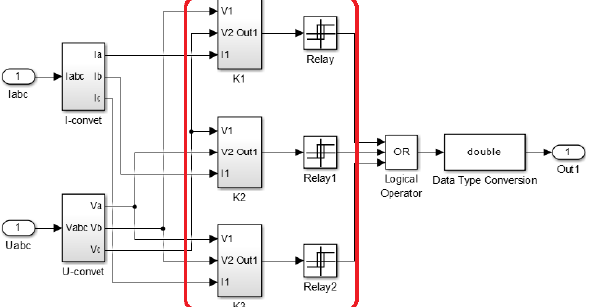
Figure 8: Distance protection data processing module